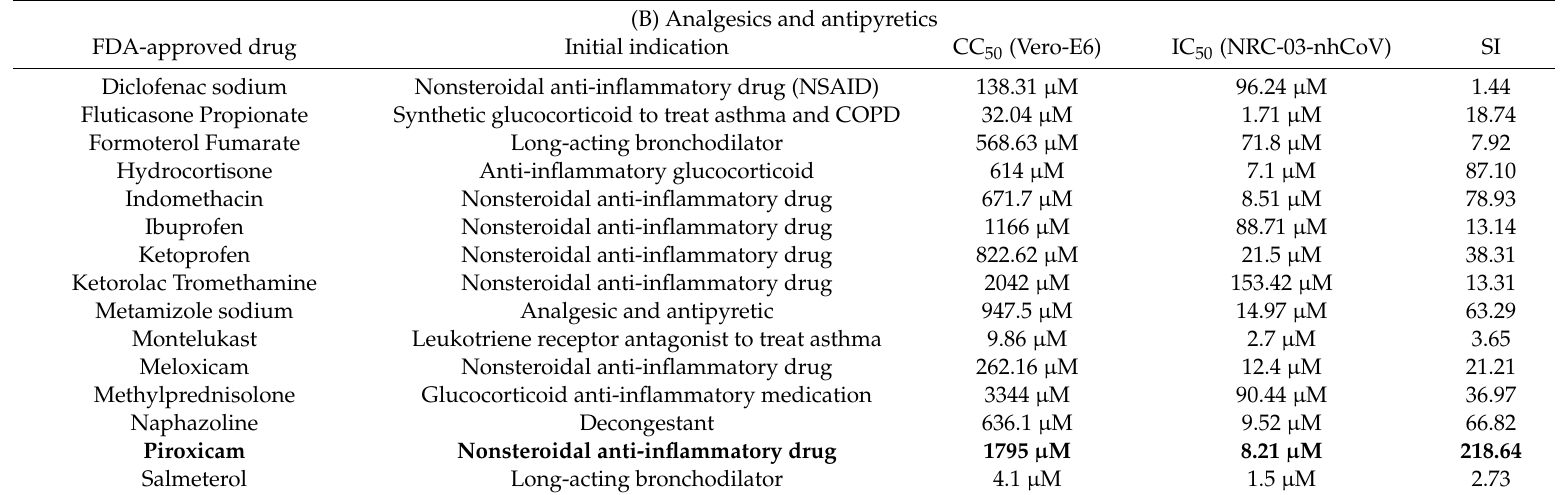
(B) Analgesics and